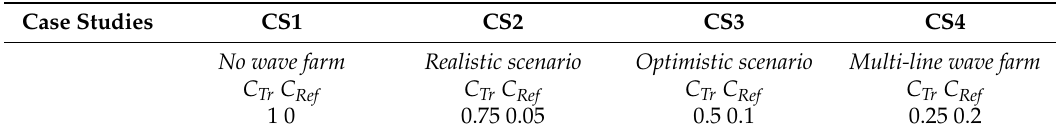
Table 2. Description of the four case studies considered